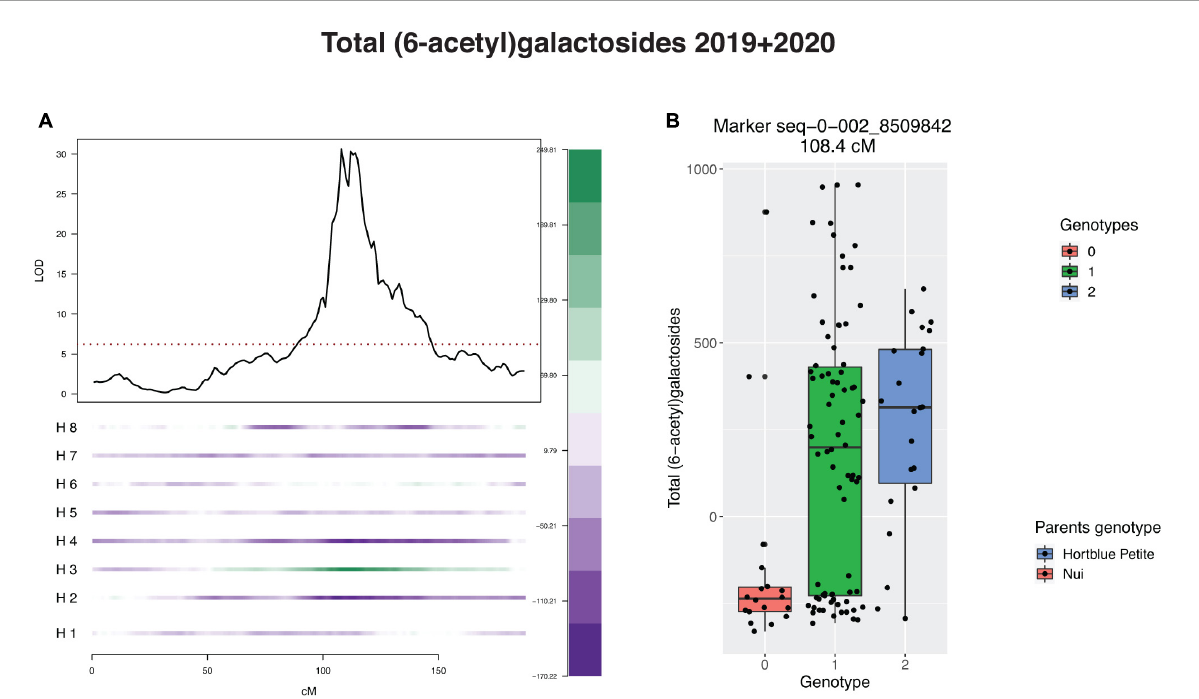
FIGURE5 Effect of major quantitative trait locus (QTL) on linkage group 2 (LG2) for total (6-acetyl)galactosides. (A) Negative (purple) and positive (green) effect of each homologue (H). H1, H2, H3, H4: homologues of “Hortblue Petite”; H5, H6, H7, H8: homologues of “Nui.” (B) Boxplot of phenotype grouped by genotype at the single nucleotide polymorphism (SNP) marker at the peak of the